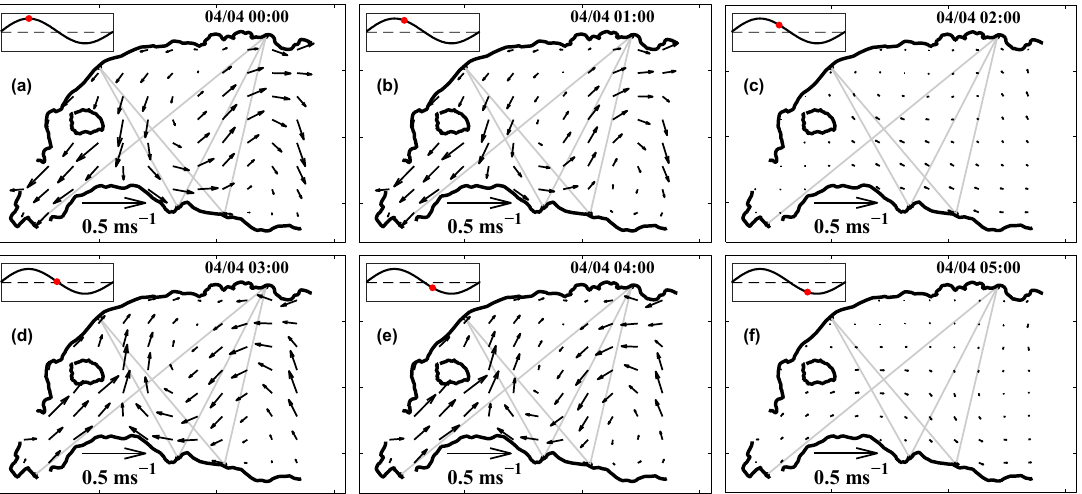
Figure 7. Hourly distributions of the inverted M 4 nonlinear current during the ebb tide from 00:00 to 05:00 ( a – f ) on 4 April 2018.